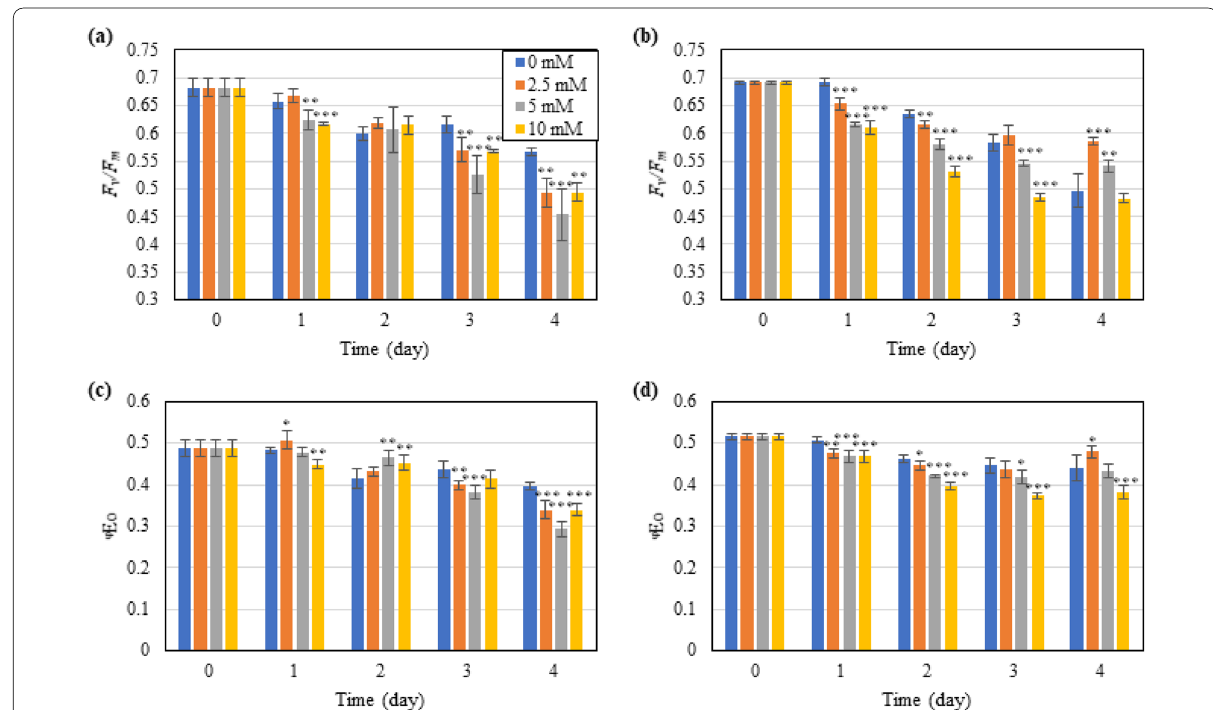
Fig. 2 Effect of exogenous GABA supply on the maximum photochemical efficiency ( F v / F m , a , b ) and quantum yield of electron transport (ΦEo, c , d ) in T. subcordiformis exposed to nitrogen deprivation under NICD ( a , c ) and HICD ( b , d ). *, **, and *** denote the significant differences at p < 0.1, p < 0.05, and p < 0.01 levels, respectively, under different GABA conditions (2.5–10 mM) compared to those under 0 mM GABA (means